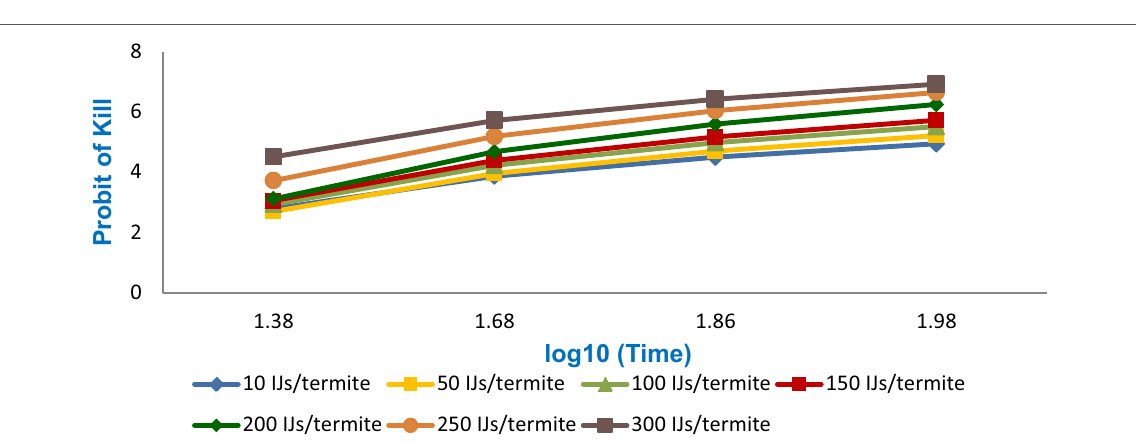
Fig. 2 Time response curve of O. obesus workers exposed to S. aciari during different time intervals and